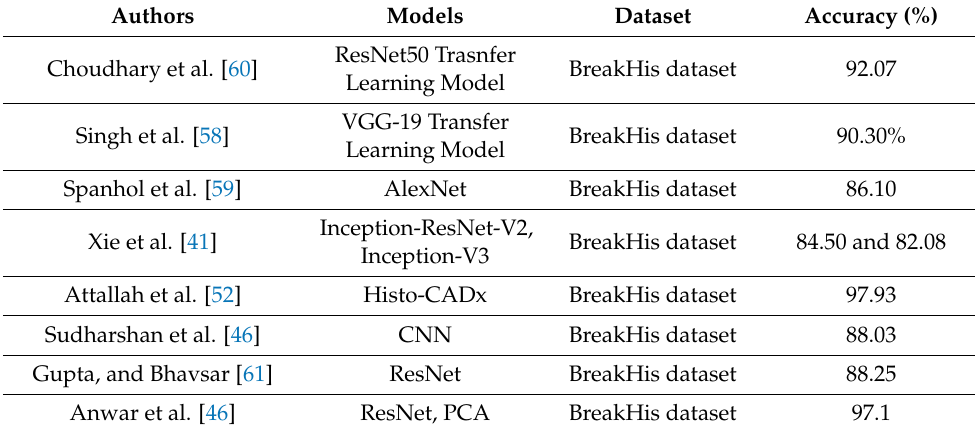
Table 9. Comparative evaluation with existing